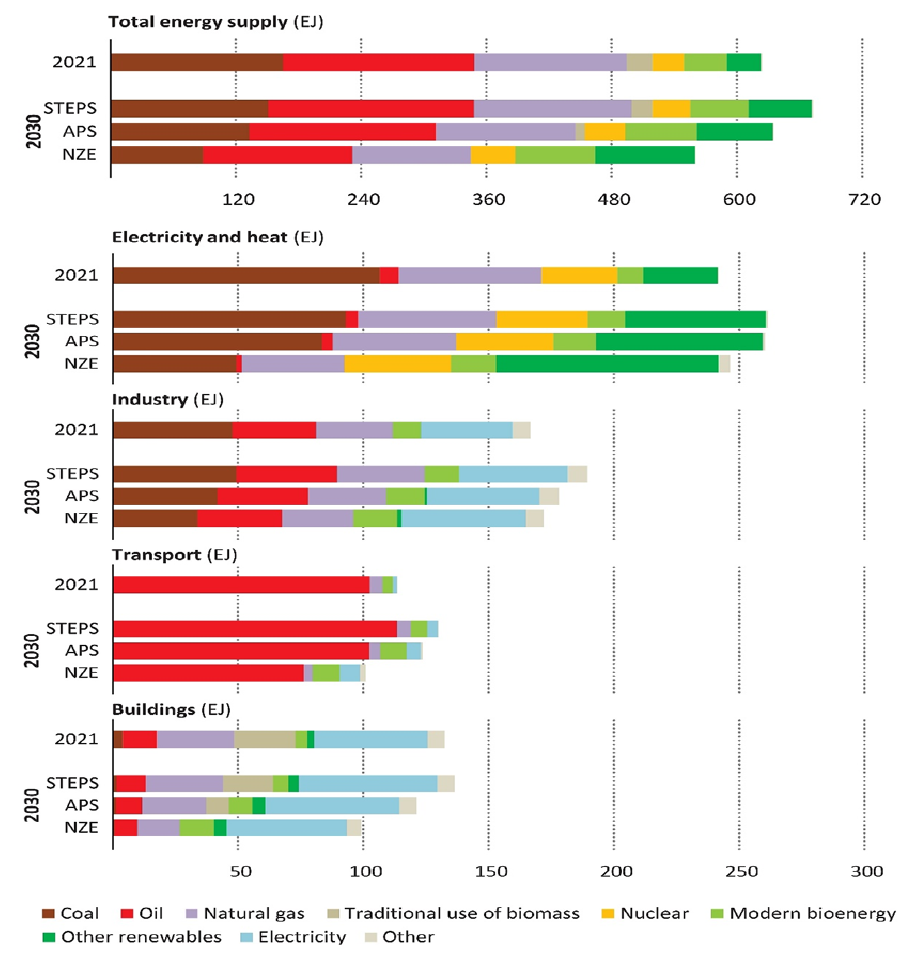
Figure 2. Global demand and supply for energy by scenario, sector, and fuel [58] .